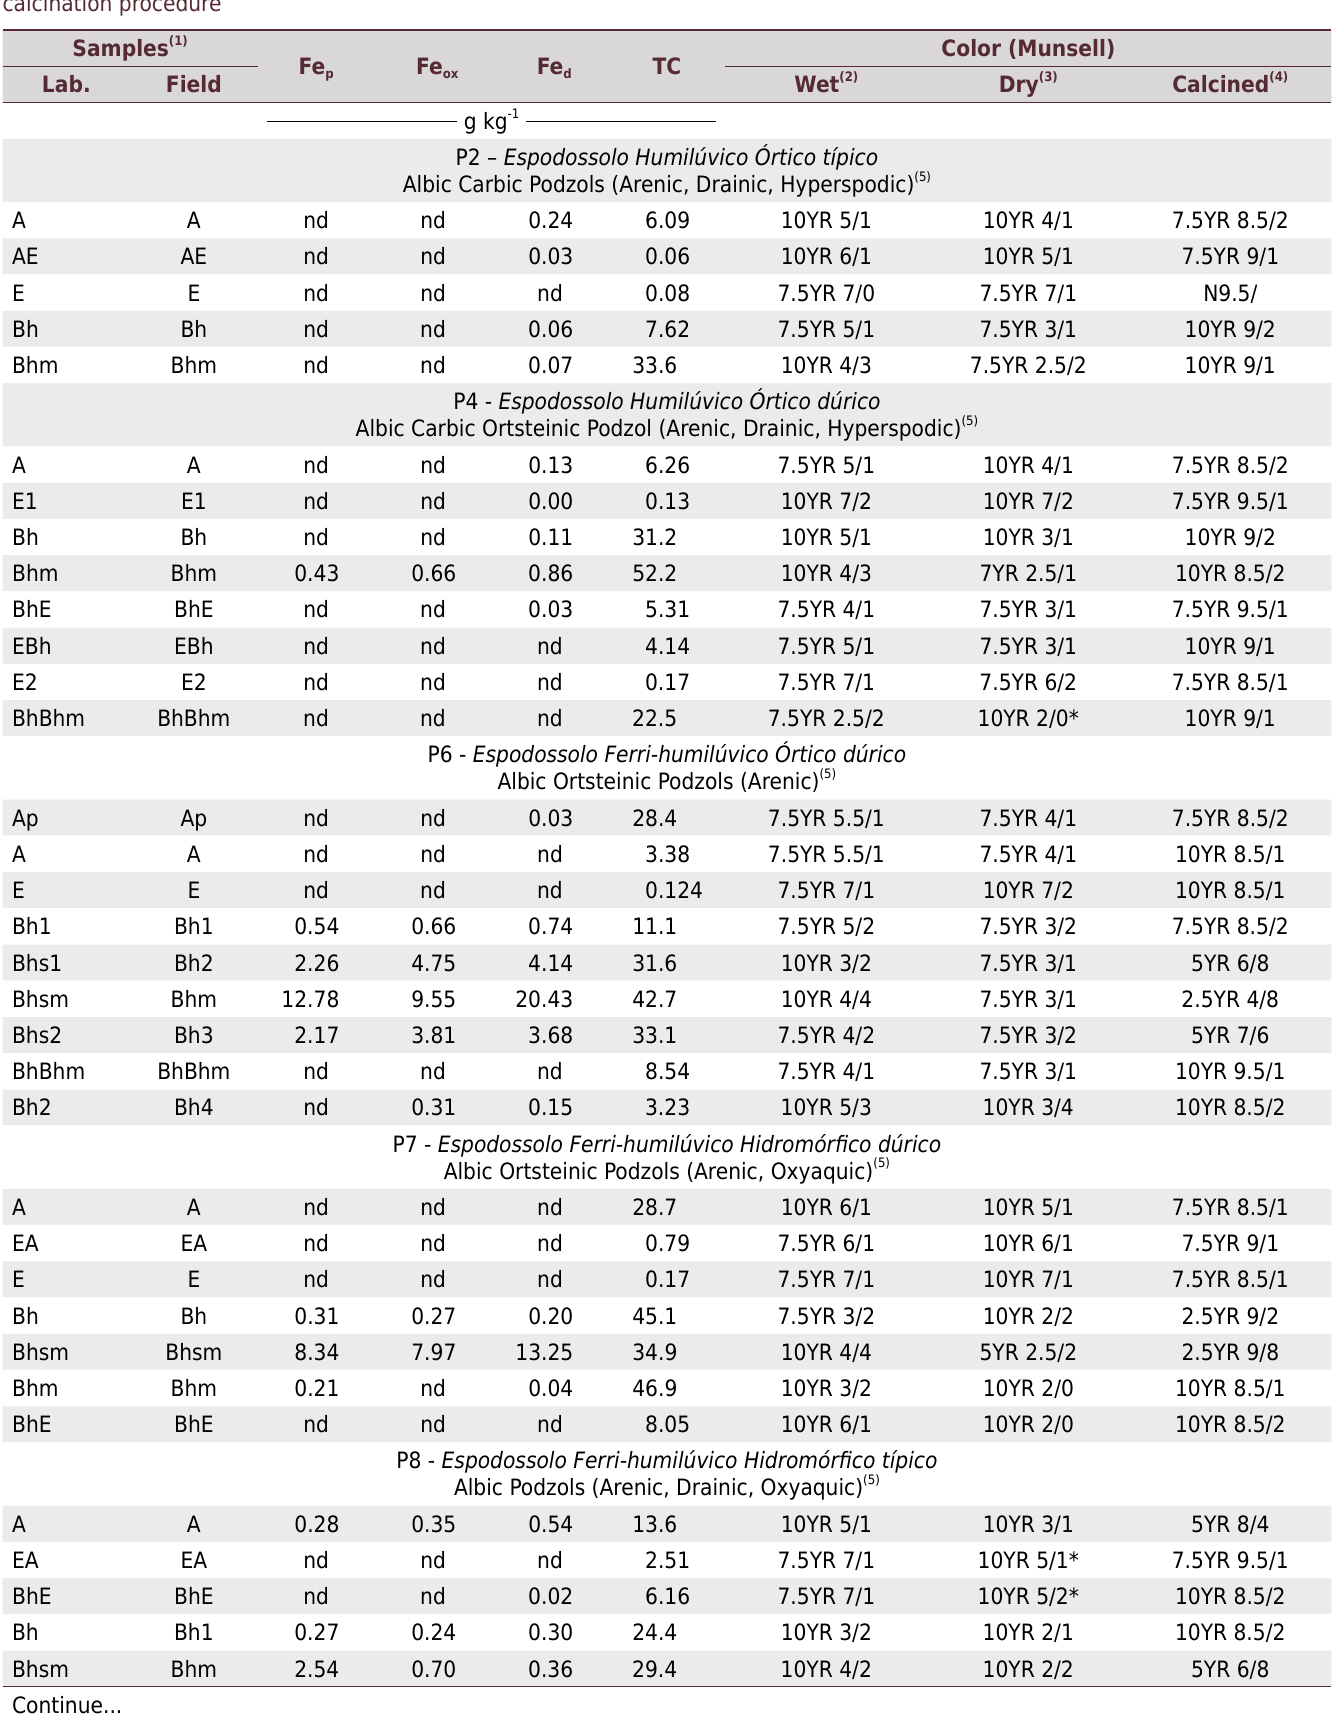
Table 1. Analytical data of total carbon (TC) and Fe contents in soil samples (Spodosols) extracted with sodium pyrophosphate (F ep ), acid ammonium oxalate (Fe ox ), dithionite-citrate-bicarbonate (Fe d ); and their colors obtained in wet basis, dry basis, and after calcination procedure Samples (1) Fe p